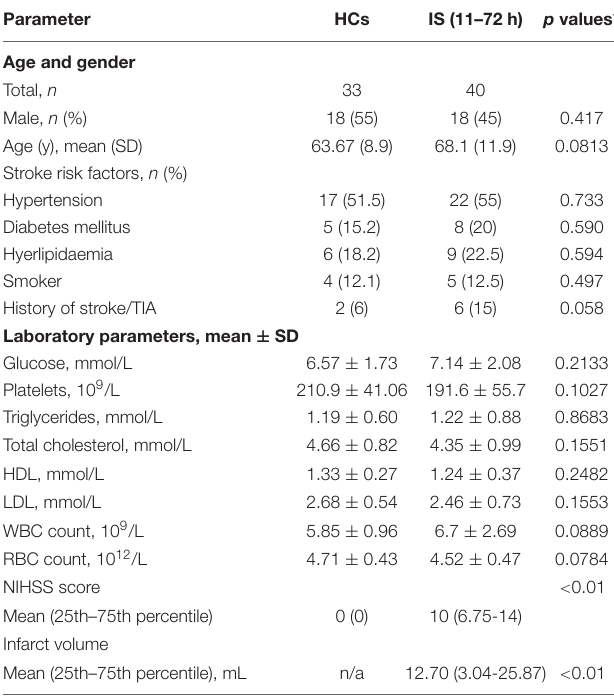
TABLE 1 | Baseline characteristics of study